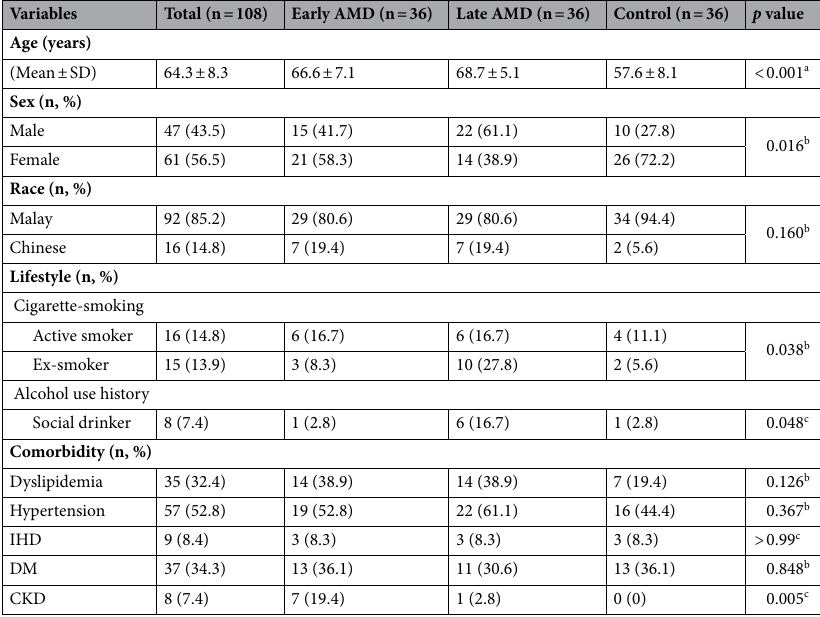
Table 1. Demographic characteristics and systemic profiles of the subjects. AMD: age-related macular degeneration, IHD: ischemic heart disease, DM: diabetes mellitus, CKD: chronic kidney disease. a One-way ANOVA. b Chi-square test. c Fisher’s exact